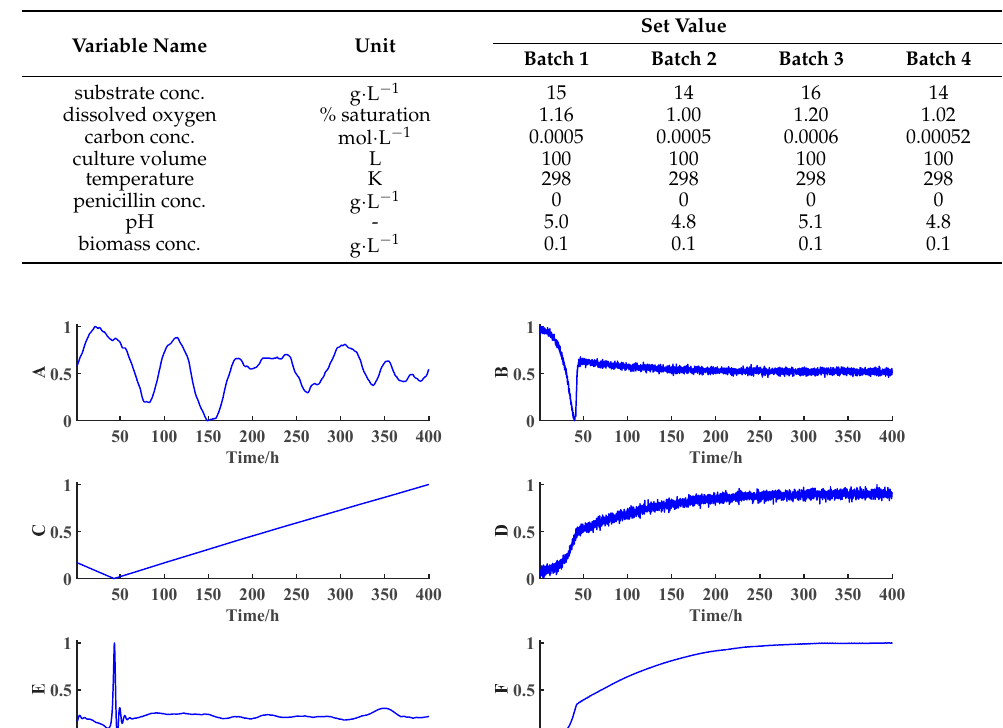
Table 1. The initial set values of the normal batches.